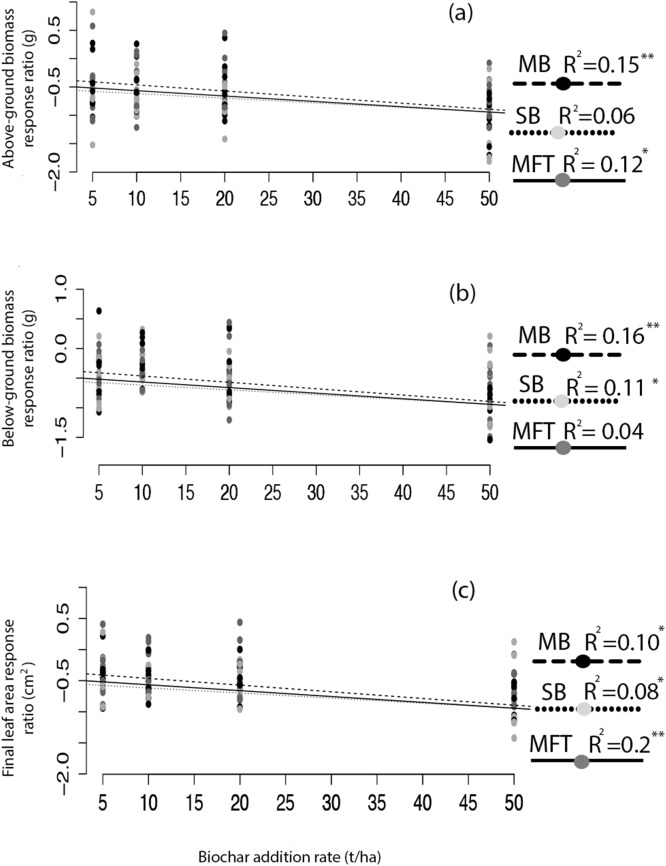
Ryegrass growth response effect size as a function of biochar addition rate.The relative effect size (response ratio–RR) of biochar treatment for aboveground biomass (A), belowground biomass (B), and leaf area (C) of ryegrass, as a function of biochar addition rate. Effect size is calculated as RR = ln(B/C), where B is mean response of the biochar treated plants, and C is the mean response of the non-biochar treated control plants. Regressions were performed for each biochar type (MB, SB, MFT); significant linear relationships are denoted with asterisks (P = < 0.05*, < 0.01**, 0.001***).